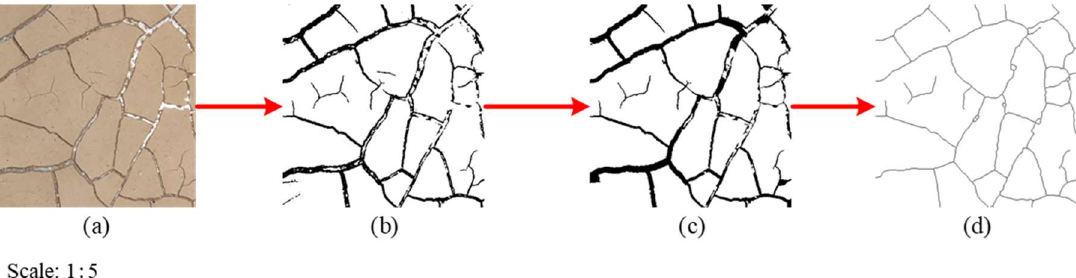
Figure 1. Processing of crack image. ( a ) Original image; ( b ) gray-scale image; ( c ) segmentation image; ( d ) skeleton image.